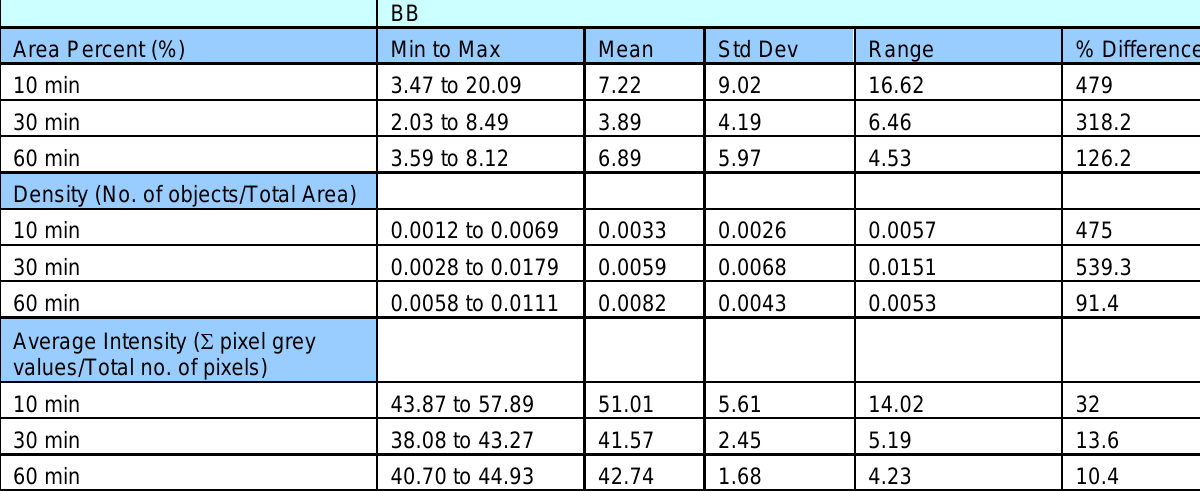
Table 1: Summary data for the experimental BB flake scrapers.